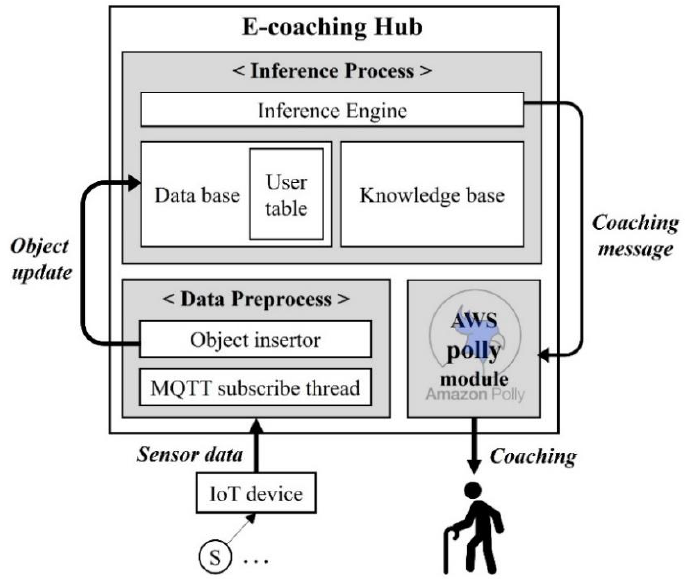
Figure 6. Main processes that compose the proposed system and the main data flows.